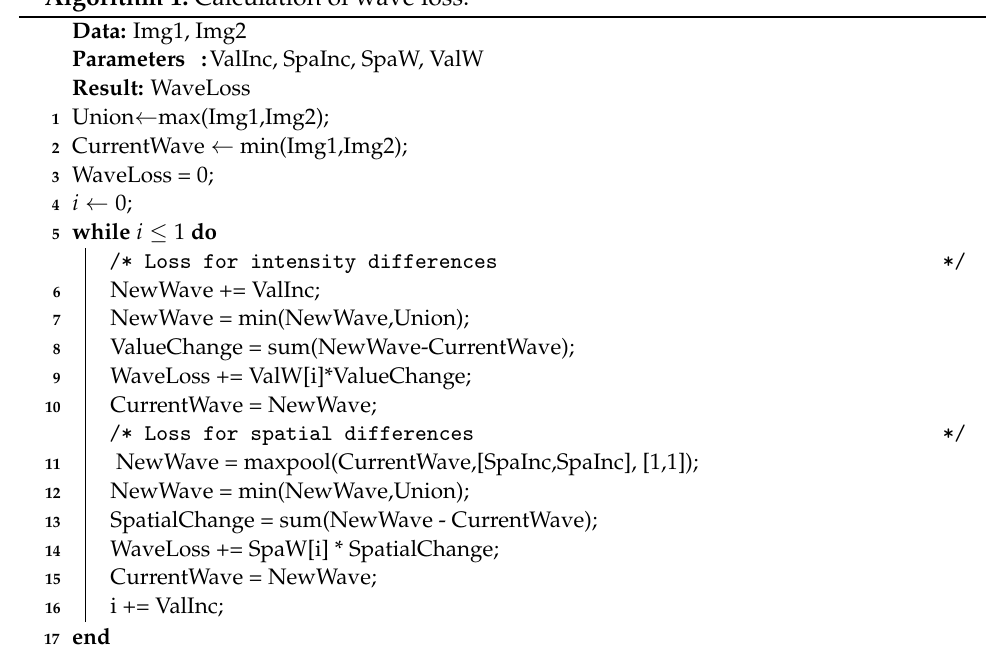
Algorithm 1: Calculation of wave